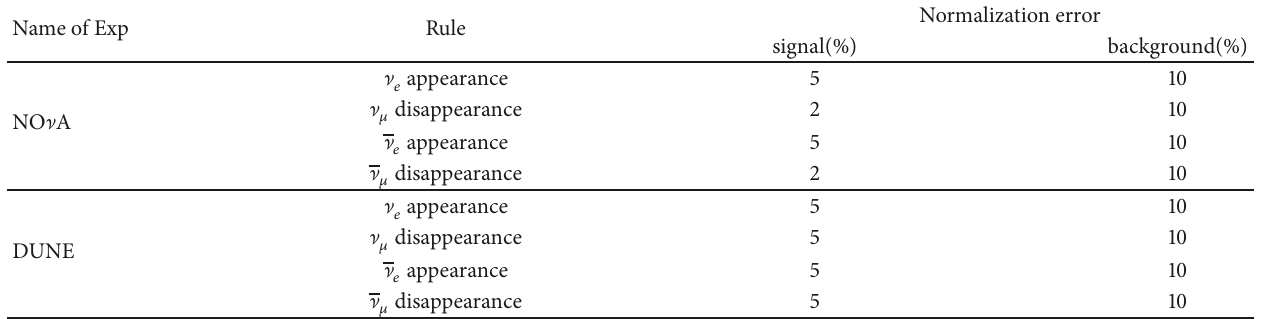
Table 2: Systematic errors associated with NO ] A and